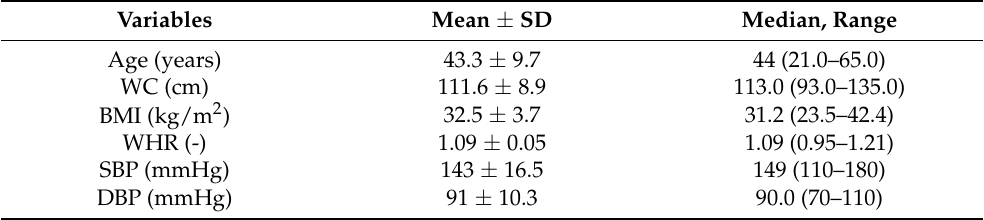
Table 1. Basic characteristics of the study